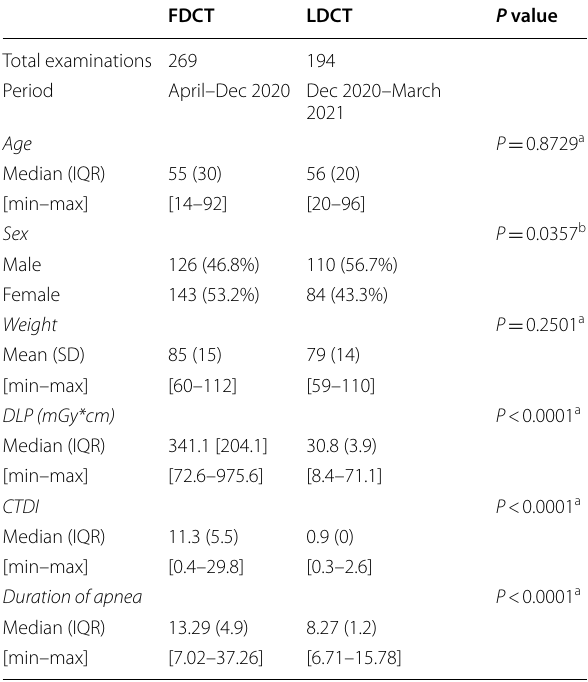
Table 2 Demographic characteristics, scanner dose and apnea duration in FDCT and LDCT groups